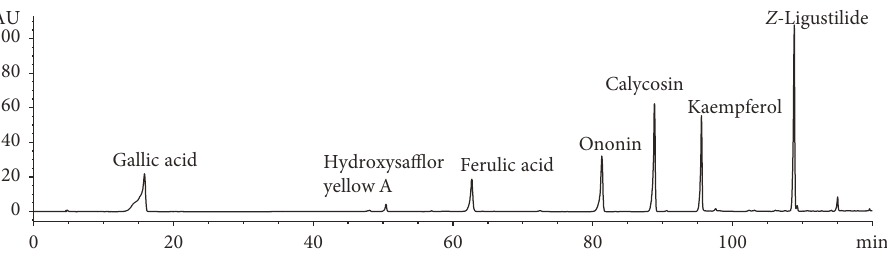
Figure 2: The HPLC fingerprint of the mixed reference